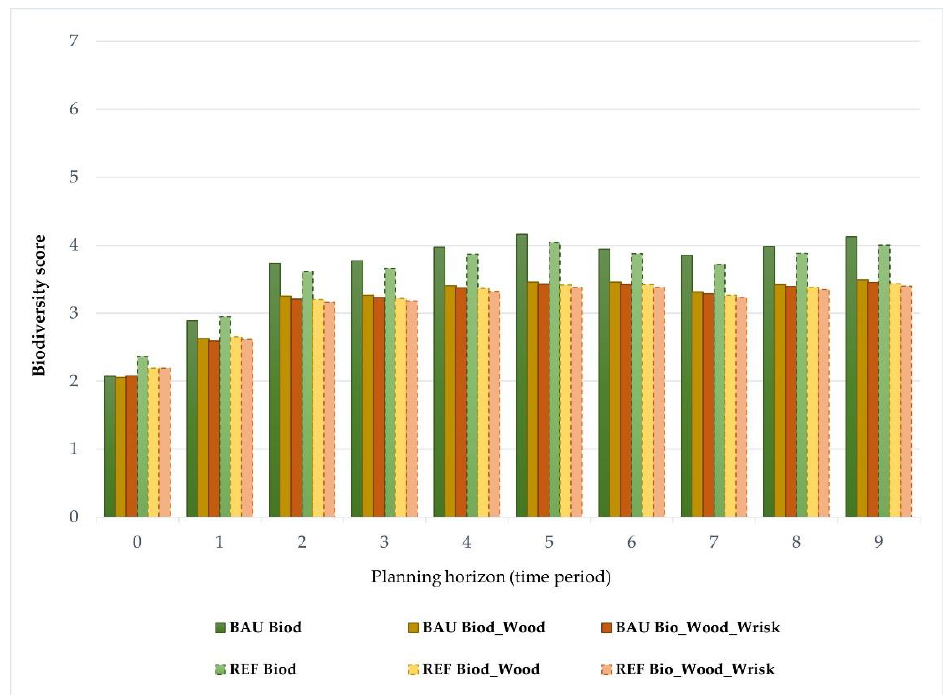
Figure 2. Trends in the supply of biodiversity for the set of the optimal-solutions and local climate current (Business as usual (BAU), solid border) and changing (high climate forcing (REF), dashed border) conditions, for each 10-year period, over the 90-year planning horizon (from t 0 = 2017 to t 9 = 2106). Table 5. Optimal LP solutions for biodiversity conservation under current (BAU) and changing (REF) local-climate conditions.